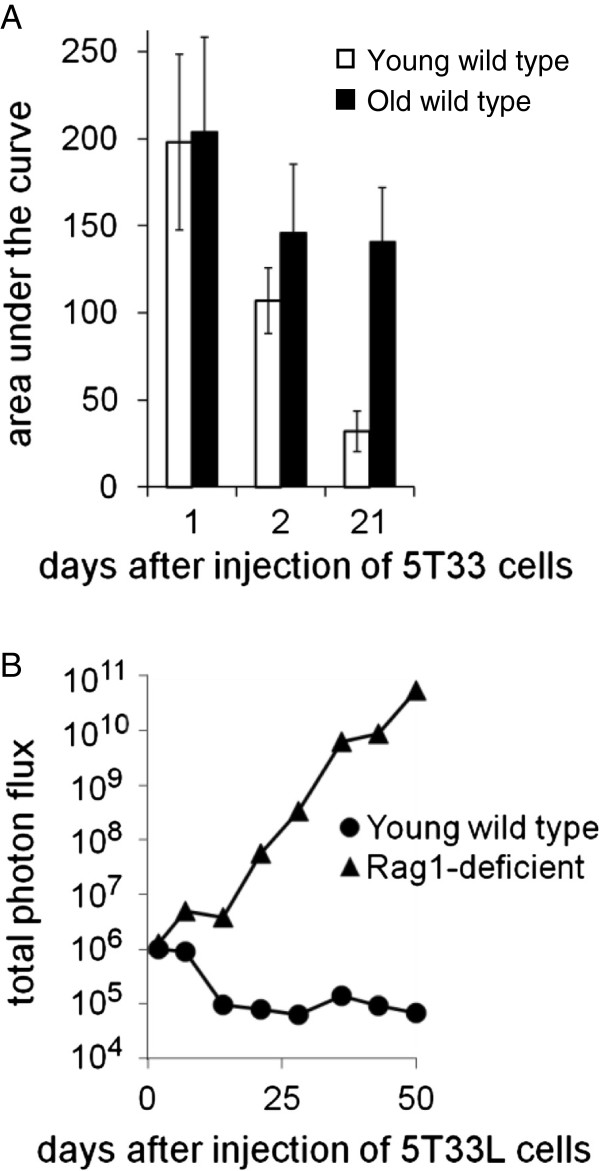
A. The number of 5T33 MMM cells in the spleen was estimated by the area of the IgH CDR3 mRNA peak with the length and sequence analysis of cDNA of 5T33 MMM cells using ImageJ Version 1.37 (NIH, Bethesda, MD). Splenic samples were obtained by partial splenectomy, 1, 2, or, at sacrifice, 21 days after injection after injection of 5T33 MMM cells. Splenic 5T33 cell number in young wild type C57BL/6 mice decreased by nearly 50% between day 1 and 2 and by 70% between day 2 and 21 following the injection of 5T33 MMM cells. In contrast, in old mice decreased only 30% and less than 5% between day 1 and 2 and less than 5% between day 2 and 21. After 21 days the index of 5T33 MMM cells remaining in the spleen was 4 fold greater in old than in young mice (p=0.036, Mann-Whitney Rank Sum Test). B. The average growth of 10 million luciferase-transfected 5T33 MMM (5T33L) cells injected into 3 young wild-type C57BL/6 mice or into 5 C57BL/6 Rag1-deficient mice by the average photon flux during the 7 weeks following the injection of 10 million 5T33L MMM cells. The average photon flux was measured using an IVIS optical imaging system after 20 minutes, 2 days, and at weekly intervals following 5T33L MMM cell infection for 7 weeks. Within 14 days the difference in the average photon flux of the C57BL/6-Rag-1-deficient and C57BL/6 wildtype mice was significantly different (p < 0.036 Wilcoxin-Mann-Whitney rank sum test) and increased progressively thereafter.